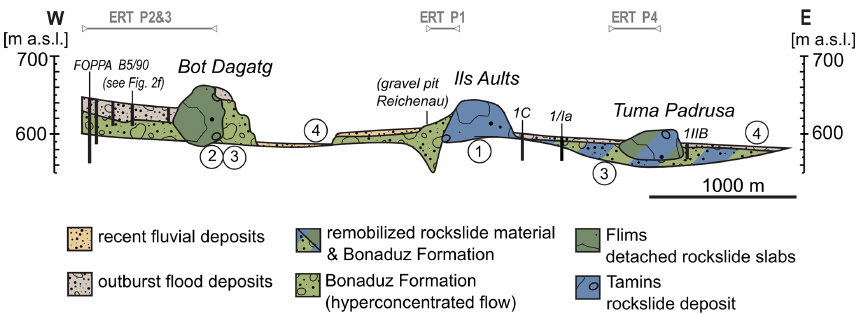
Figure 5. Schematic cross section interpreted from the presented ERT surveys (indicated in grey). Drilling data indicated by black bars supported the interpretation of the depth. The projection of ERT profile P1 leads to a V-shaped body in the cross section. The circled numbers correspond to the evolution phases